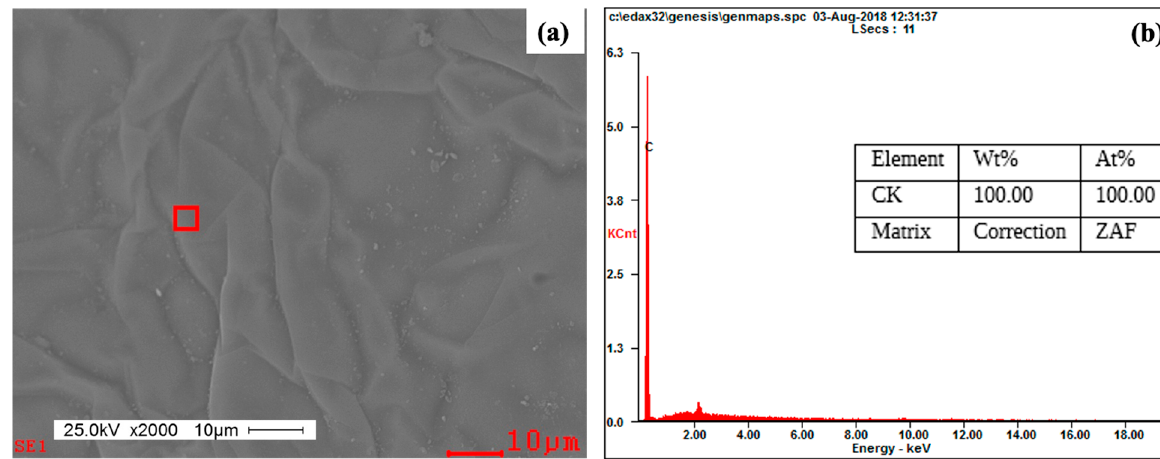
Figure 1. Images showing ( a ) the SEM micrograph of PG and ( b ) the EDAX spectrum of single peak carbon. The inset in ( b ) is the weight and atomic fractions of carbon in graphite.